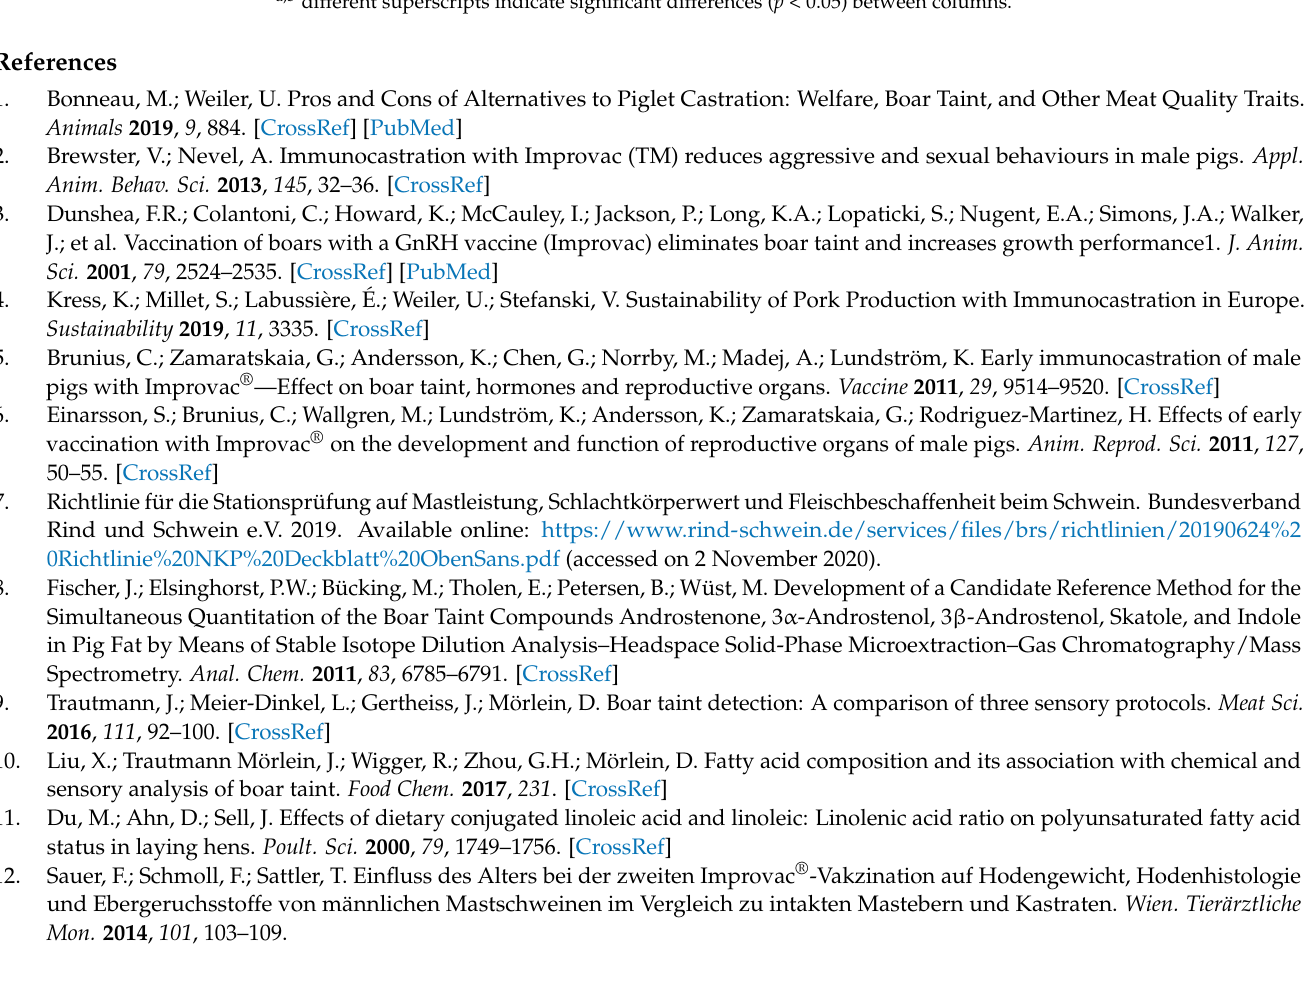
Table A3. Boar taint (measured in shoulder fat) according to immunization scheme and trial run. Interaction of Immunization (Control, Early) and Trial Run (1–3)